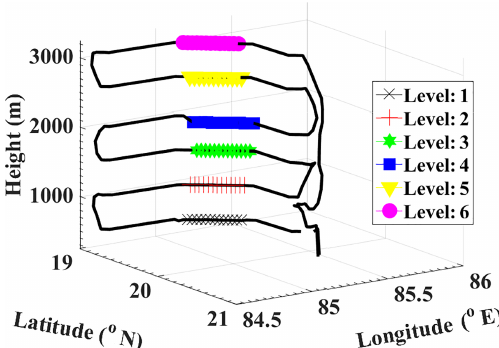
Figure 2. Typical course of the aircraft during a campaign sortie. Symbols represent stable levels. Each stable level represents a min- imum of 20min of scientifically useful